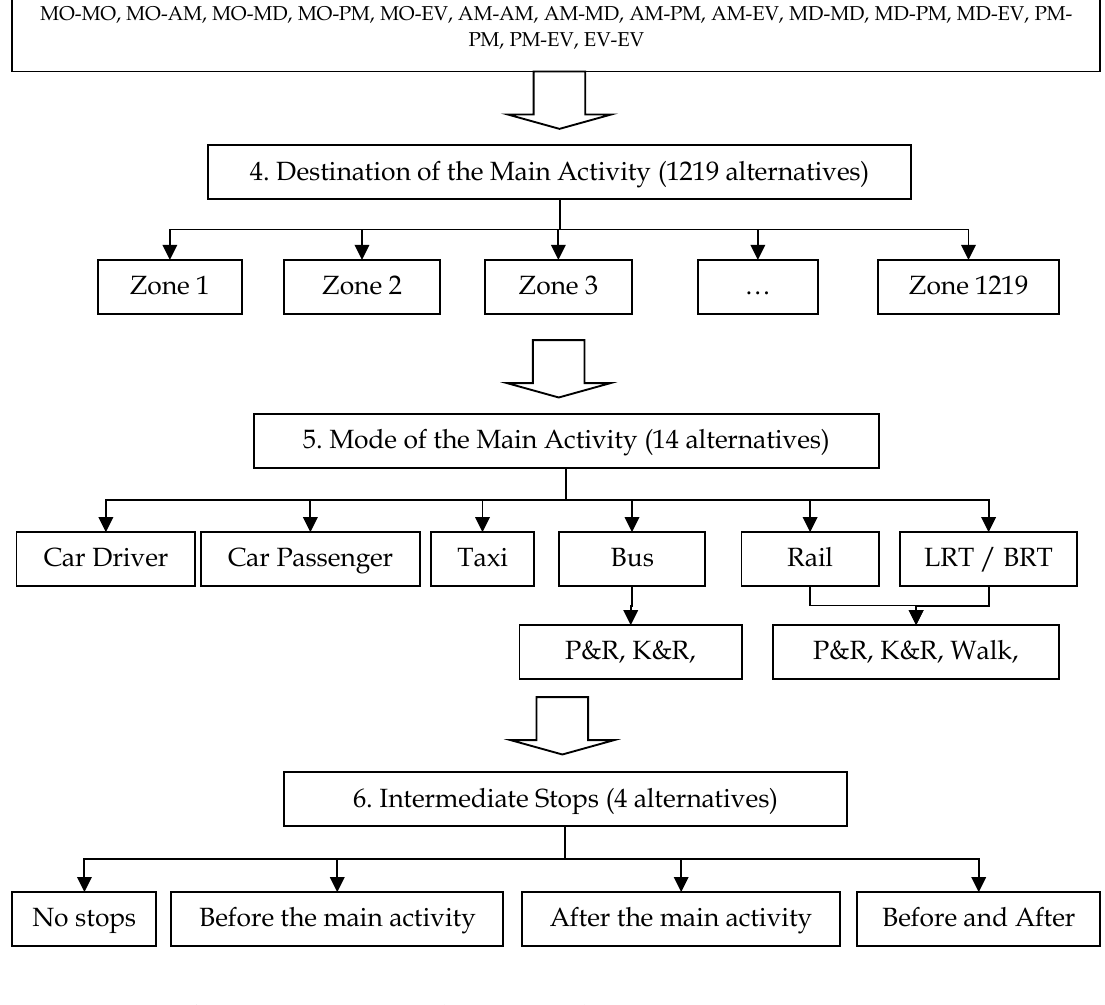
Figure 2. Tel Aviv ABM structure (primary